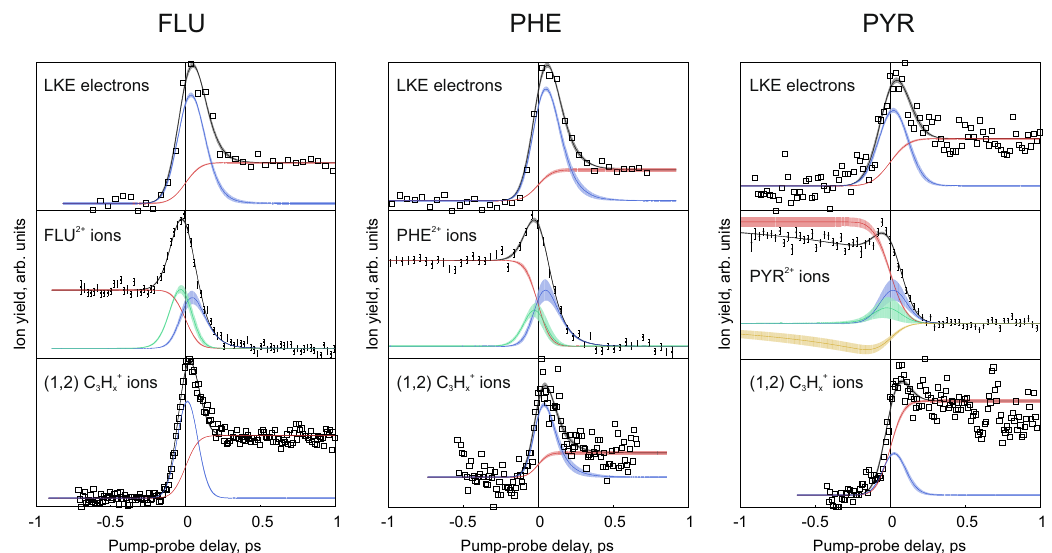
Fig. 5 Delay dependent yields and fi ts. Delay-dependent yields of the LKE electrons, PAH 2 + , and C 3 H þ x ions from the (1, 2) channel formed from FLU, PHE, and PYR. The vertical black line represents t 0 . LKE electrons are de fi ned as having a kinetic energy below 2 eV. Details for the fi tting procedure are described in the Methods section. The blue and green peak functions represent the XUV-pump, IR-probe and the IR-pump, XUV-probe laser regimes, respectively. The red sigmoidal curves represent the change in signal due to different PAH ionization states populated by the pump laser. The PYR 2 + curve additionally contains another peak function (in yellow) to account for slowly changing IR-pump dynamics reproduced over multiple measurements. The black curves show the sum of the peak functions and sigmoidal. Each data point in the PAH 2 + plots results from averaging 1300 ± 200, 2000 ± 400, and 900 ± 400 measurements for FLU, PHE, and PYR, respectively (variation arises from sorting and fi ltering according to jitter in the FEL pulse timing).